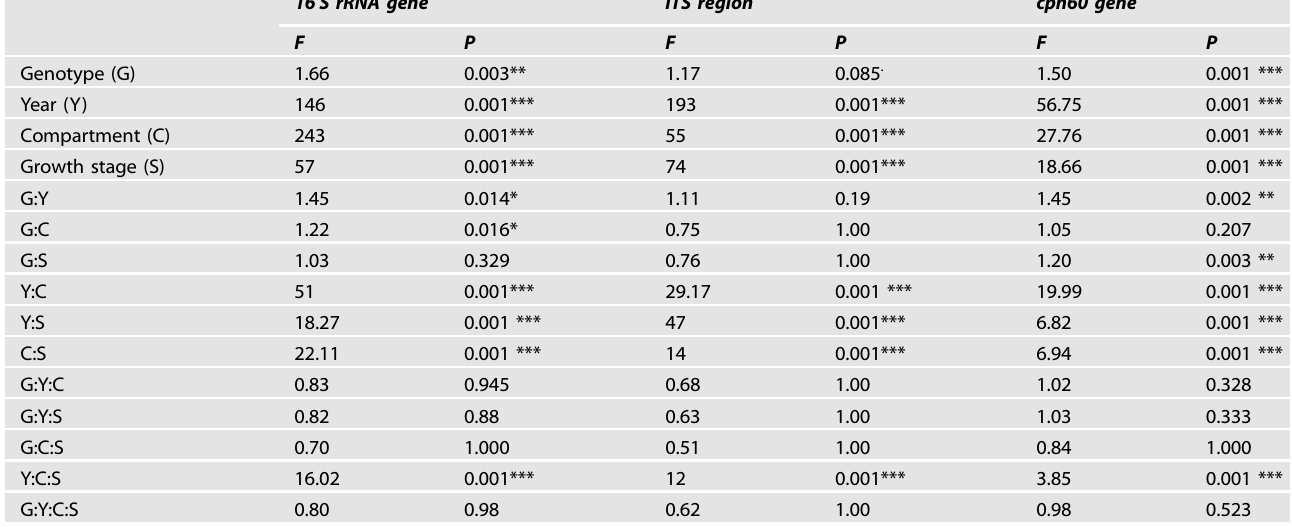
Table 2. Permanova analysis for the effect of genotype per year, compartment, and growth stage for 16 S rRNA gene, ITS region and cpn60 gene amplicon datasets generated from bulk soil, wheat rhizosphere soil and wheat roots collected from 2013-2016 at the stem elongation and dough development